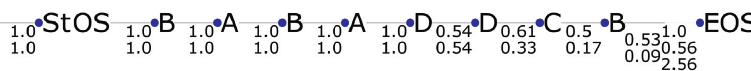
Figure 20: Output of the seq2probTree method for the tree-based system with input sequence [B A B A D].